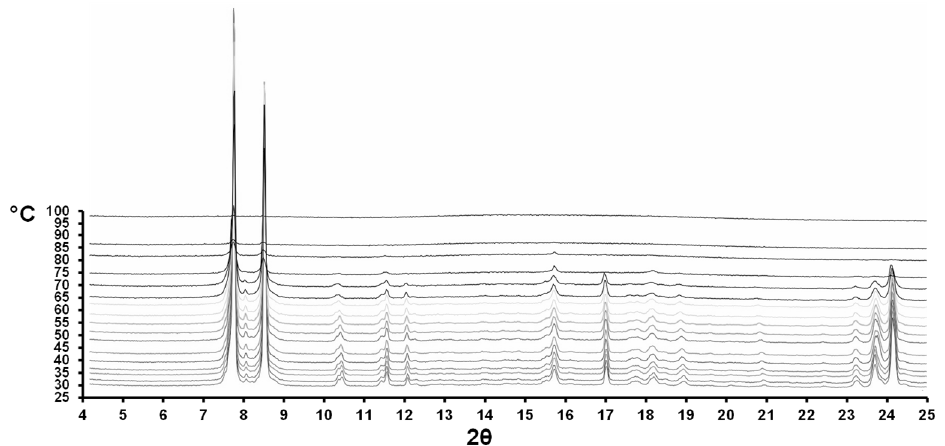
Figure 8. Two-dimensional contour plot as a function of 2 θ and temperature for the collection of PXRD patterns measured at elevating temperatures in the range of 25–100 °C for Moxi·2 i PrOH. The collection of PXRD patterns shows that, by raising the temperature, the sample loses crystallinity at about 70 °C, and becomes amorphous. No peak shifts are observed. As a sign of amorphization, the lowering of peak intensities, starting from 65 °C, is observed. The sample can be considered fully amorphous at about 85 °C.